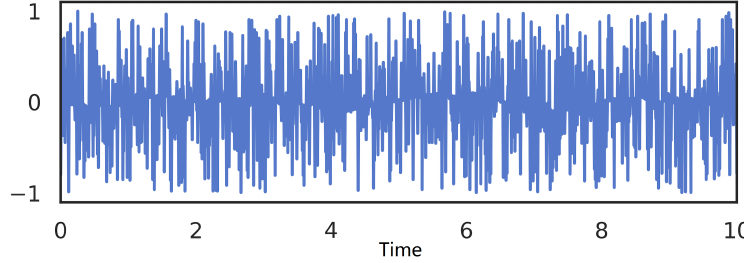
Figure 1. The underwater acoustic ship signal.